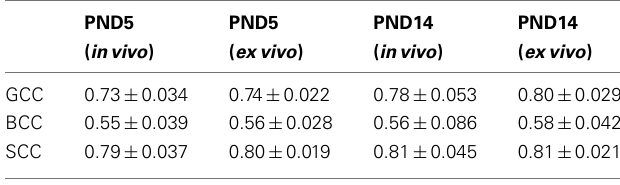
Table 1 | Fractional anisotropy comparison between the in vivo and the ex vivo scans for PND5 and PND14 rat pups.